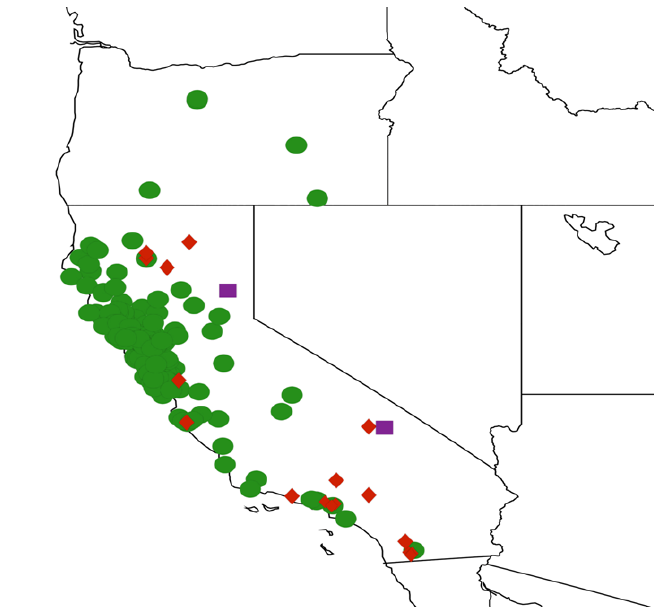
Figure 40. Distribution of Platypedia minor (green circles), P. rufipes (red diamonds), and P. sylvestri (purple